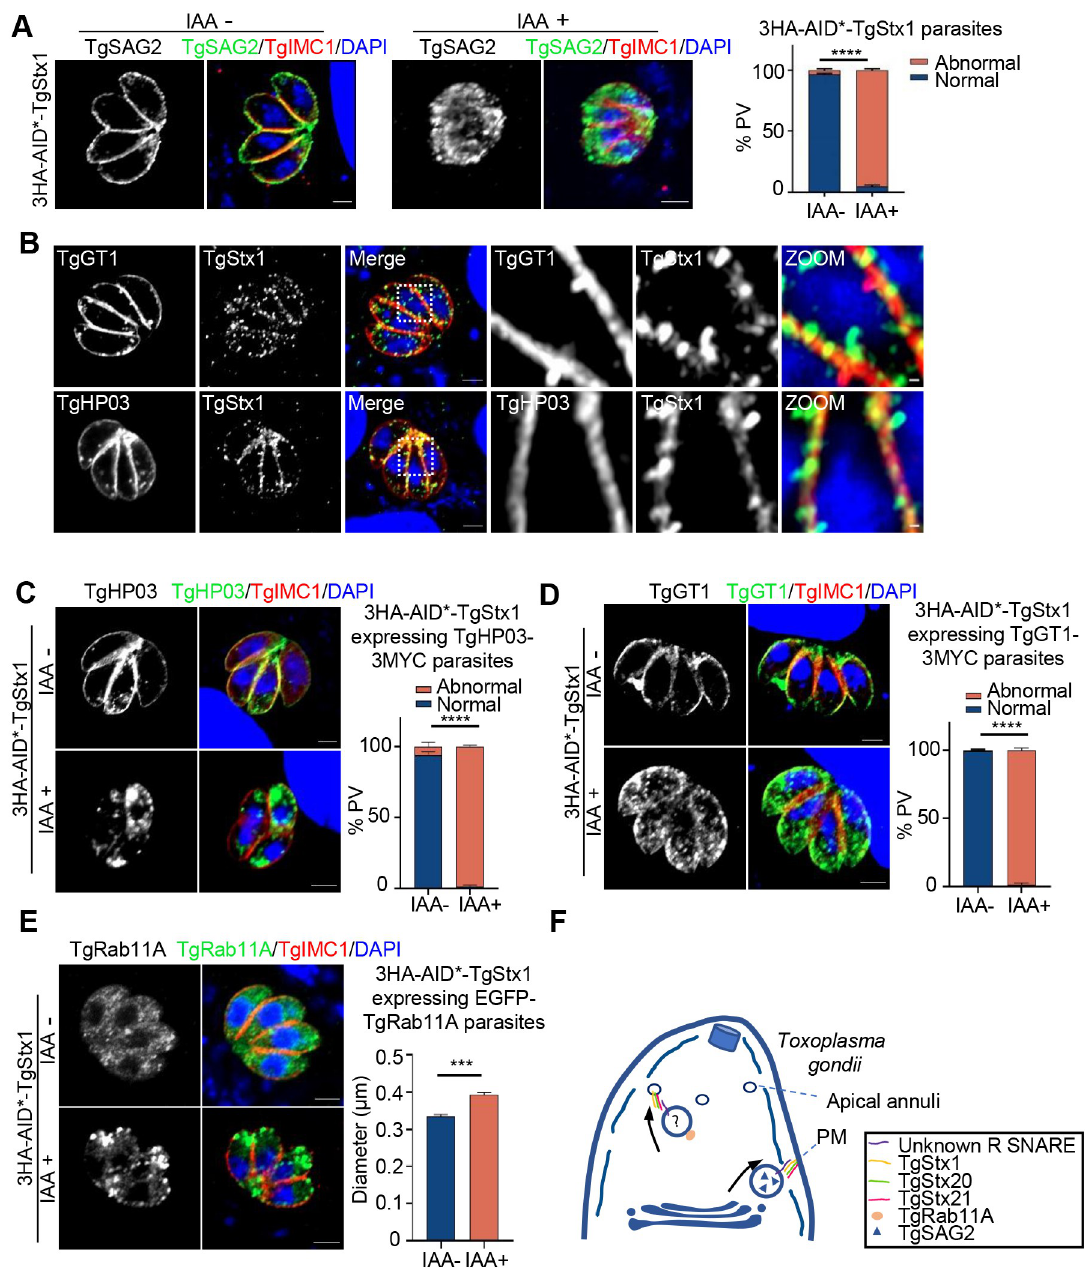
Fig 6. TgStx1 is required for exocytosis at the plasma membrane. ( A ) IFA showing that conditional ablation of TgStx1 affected the trafficking of TgSAG2 (green) to the plasma membrane. The parasite cortex was stained with a rabbit anti-TgIMC1 antibody (red). Scale bars: 2 μ m. Data show mean ± SEM of three independent experiments and statistical differences were analyzed by the unpaired t-test; **** P < 0.0001. ( B ) IFA showing that TgStx1 (green) partially colocalized with TgHP03 (red) and TgGT1 (red). 3HA-AID * -TgStx1 parasites were transfected with a plasmid expressing 3MYC-tagged TgHP03 or TgGT1, selected using pyrimethamine, and then analyzed by an IFA. Scale bars: 2 μ m (left panels) and 0.2 μ m (zoomed panels). ( C ) and ( D ) IFA showing that TgHP03 (green) and TgGT1 (green) were retained in intra-cytosolic vesicles following treatment of 3HA-AID * -TgStx1 parasites with IAA for 24 h, but were located at the membrane without IAA treatment. The parasite cortex was stained with a rabbit anti-TgIMC1 antibody (red). Scale bars: 2 μ m. Data show mean ± SEM of three independent experiments and statistical differences were analyzed by the unpaired t-test; **** P < 0.0001. ( E ) IFA showing that TgRab11A (green) aggregated at the apical annuli following treatment of 3HA-AID * -TgStx1 parasites with IAA for 24 h, but was distributed in the cytoplasm without IAA treatment. The parasites were transfected with a plasmid expressing FKBP-EGFP-TgRab11A, selected using pyrimethamine, and then analyzed by an IFA. The parasite cortex was stained with a rabbit anti-TgIMC1 antibody (red). The longest diameters of the TgRab11A puncta were measured using the distance tool of ZEN